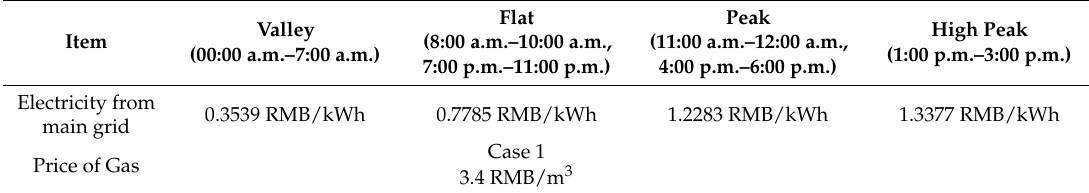
Table 1. Energy tariff in Case